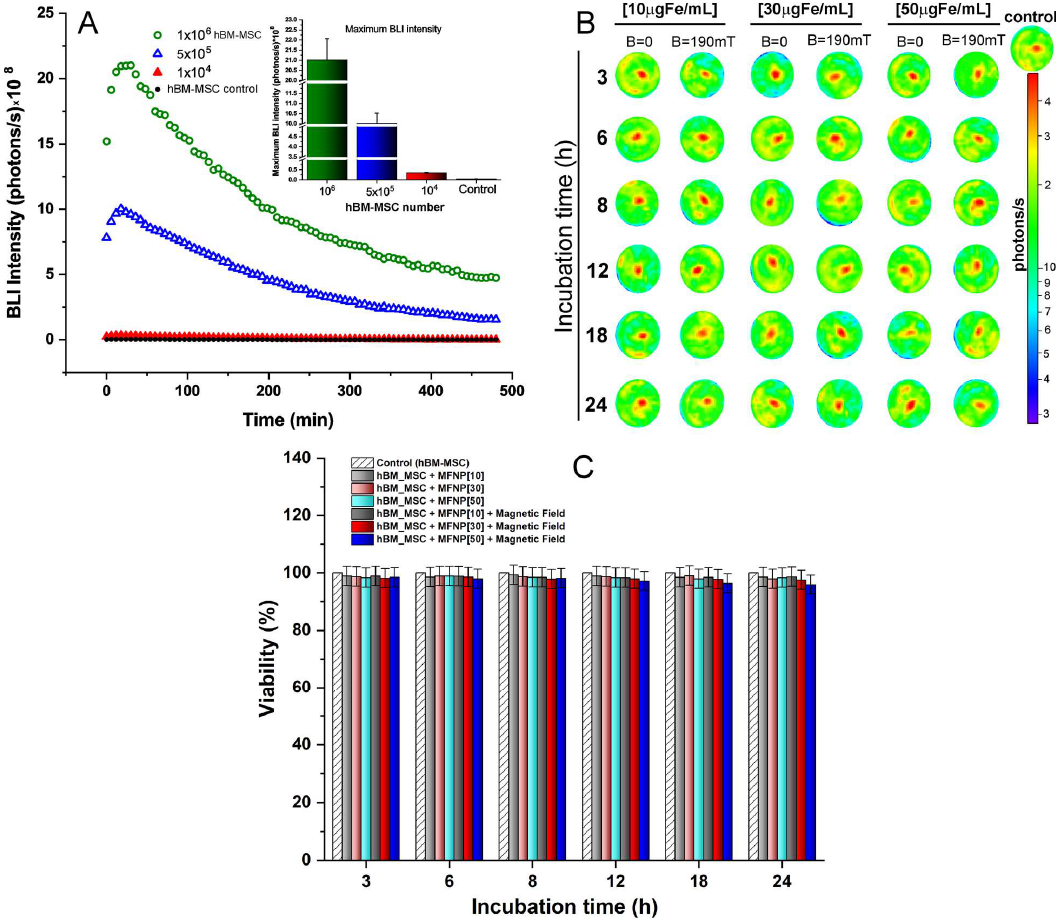
Figure 4. Bioluminescent (BLI) evaluation in vitro. ( A ) The BLI kinetics of the hBM-MSC Luc according to cell concentrations (represented by green, blue, and red symbols) and the respective controls (represented by empty black symbols), following by the BLI signal intensity quantification, shown in the inset graphic. ( B ) The bioluminescence signal intensity of the hBM-MSCs transfected after labeling with MFNP in different concentrations (10, 30, and 50 µg Fe/mL) and periods of incubation (3 to 24 h). ( C ) The cellular viability in all conditions was analyzed. Table 1. The percentage of cellular viability after the hBM-MSC labeling with MFNP in the presence or absence of a magnetic